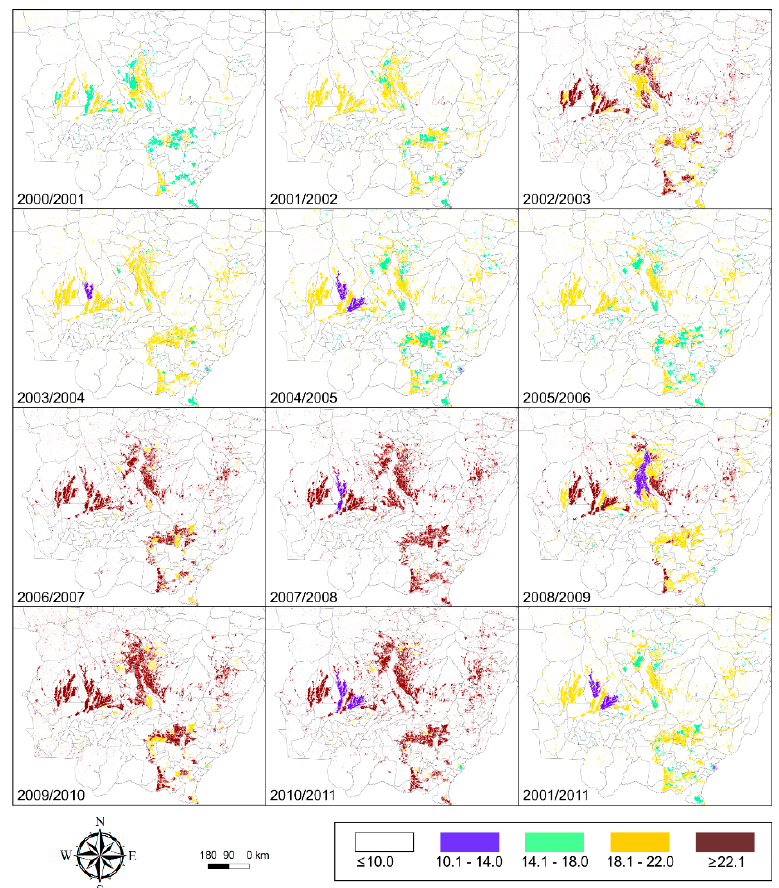
Figure 12. Gaussian areal kriging prediction standard error of the soybean crop yield (total number of 60-kg bags per ha − 1 ) inside the soybean-harvested areas that were detected by remote sensing, per harvest period (2000/2001 to 2010/2011) and the averaged years (2001/2011).